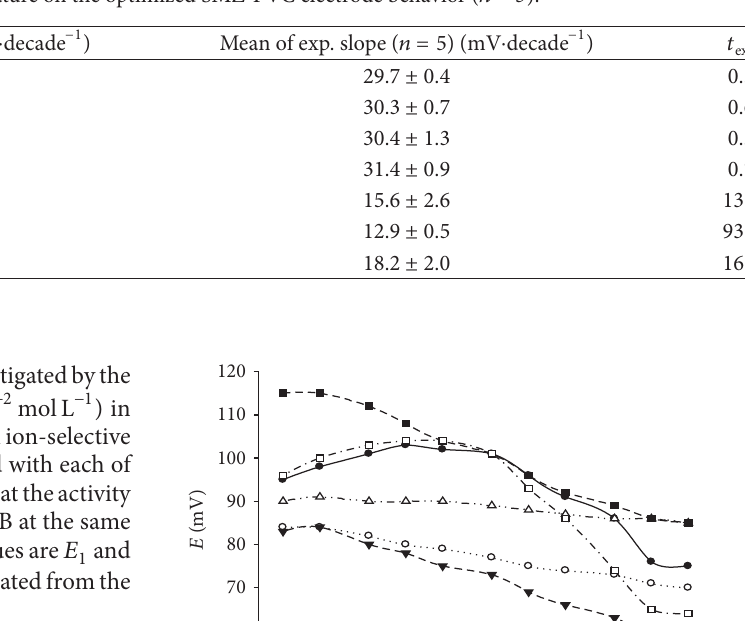
T 6: Effect of temperature on the optimized SMZ-PVC electrode behavior (